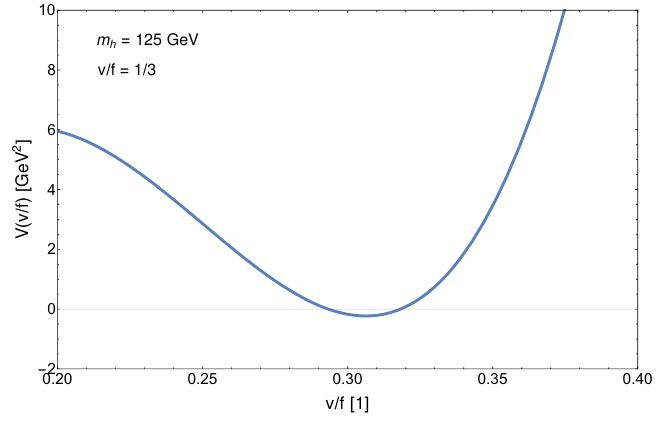
Figure 8 . The Coleman-Weinberg potential in our model. The minimum is at v=f = sin ( h h i =f ) = 0 : 3 and the Higgs mass is